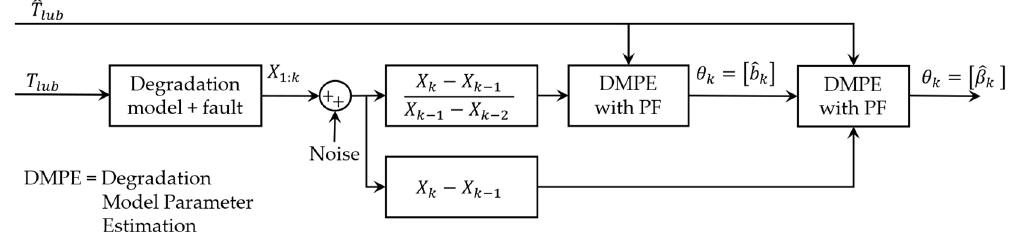
Figure 13. Result of the estimated ( a ) 𝑏(cid:3552) and ( b ) 𝛽 (cid:3552) using the one-step online parameter estima- tion method.